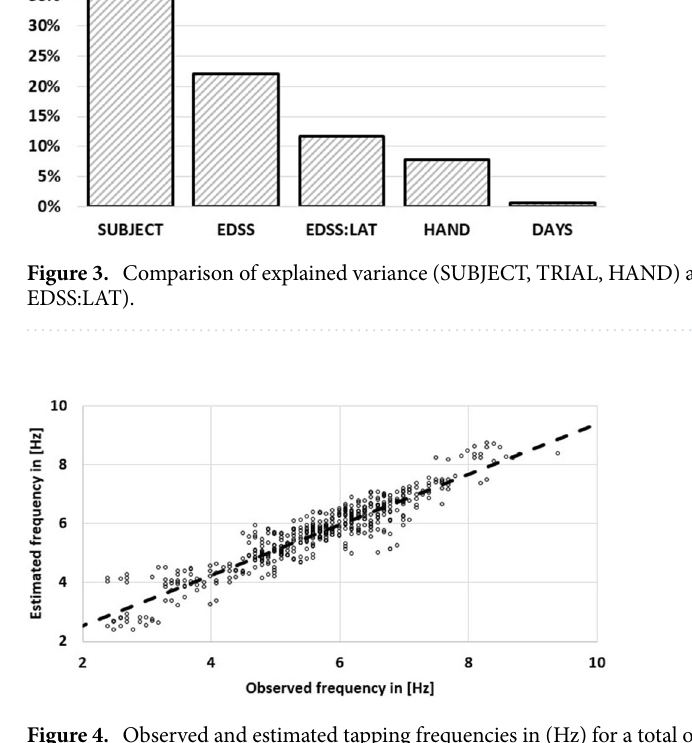
Figure 4. Observed and estimated tapping frequencies in (Hz) for a total of 480 data points (40 subjects × 3 sessions × 2 trials × 2 hands). The regression has an explained variance of 0.87 (p <